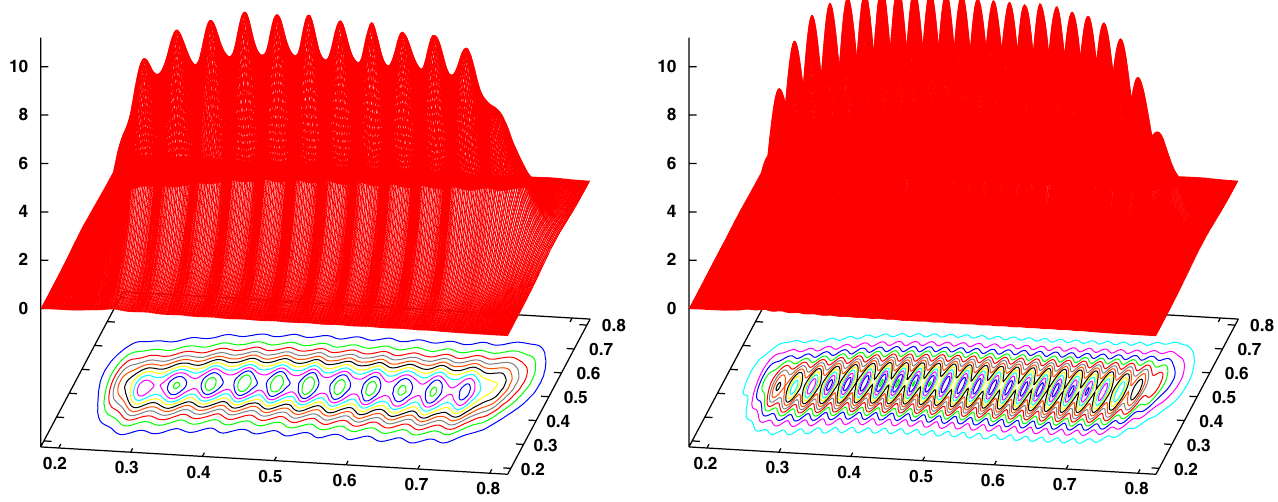
Þ at s ¼ s ¼ 200 (cid:4) m (left) and (cid:2) ; x for (cid:2) f 1 2 0